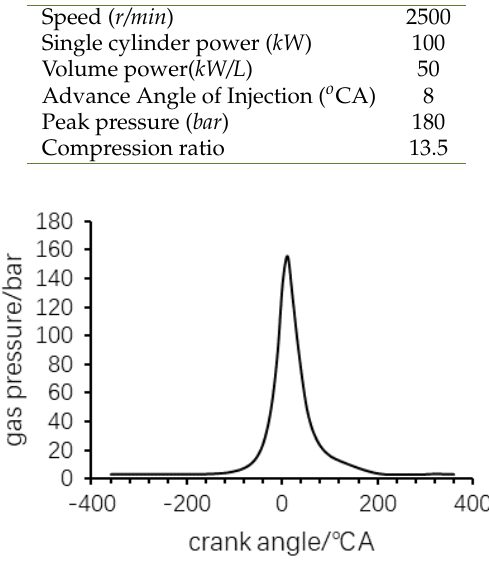
Fig. 1. Indicator diagram of a diesel engine main performance data required by the simulation analysis software (as shown in Table 1) are measured. Based on this, the one-dimensional engine performance simulation analysis is carried out by using GT-Power software. Fig. 1 is the indicator diagram of diesel engine with the change of crankshaft angle under intensified working